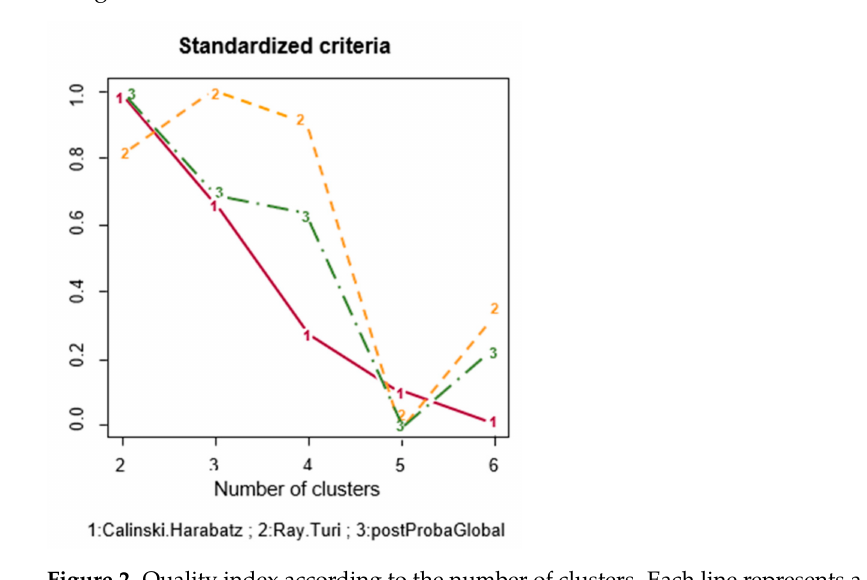
Figure 2. Quality index according to the number of clusters. Each line represents a different quality index, and depicts the resulting changes according to the number of clusters. Each quality index has been normalized to a value between 0 and